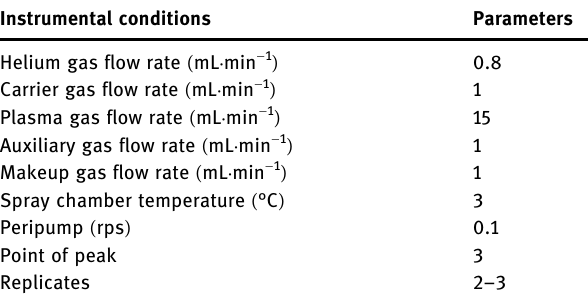
Instrumental conditions Parameters